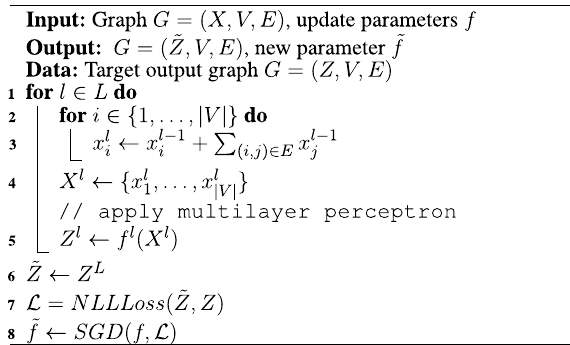
Algorithm 1. GCN computation + parameter